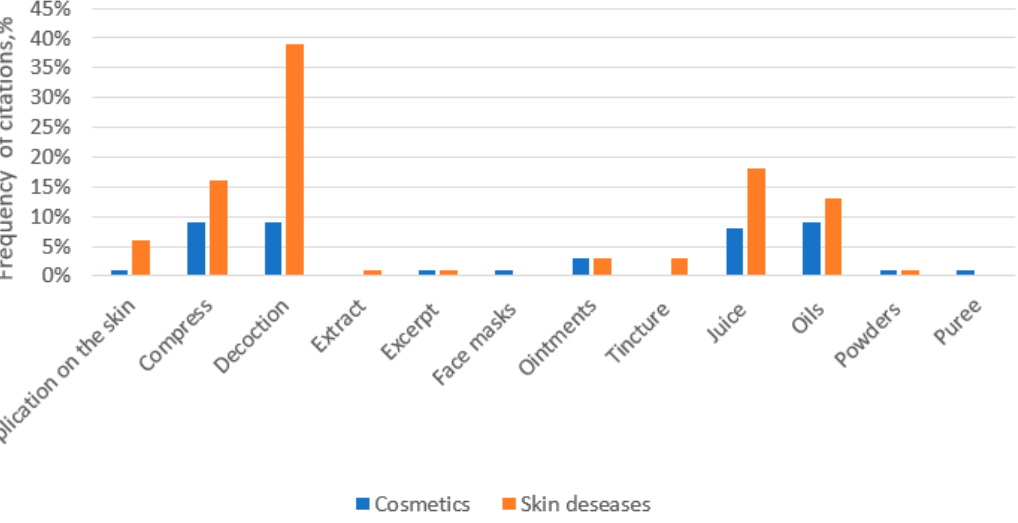
Figure 4. Methods of ethnopharmaceutical preparation for the treatment of skin diseases and cos- metics.